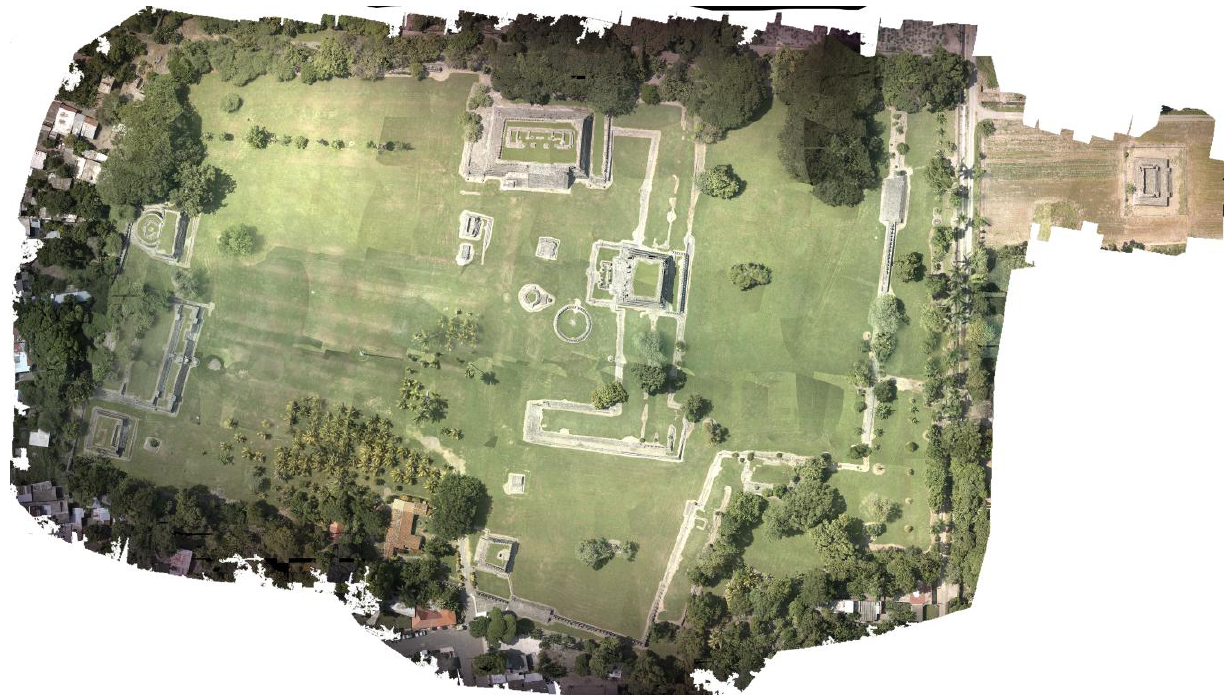
Figure 11. Orthophoto of the archaeological site of